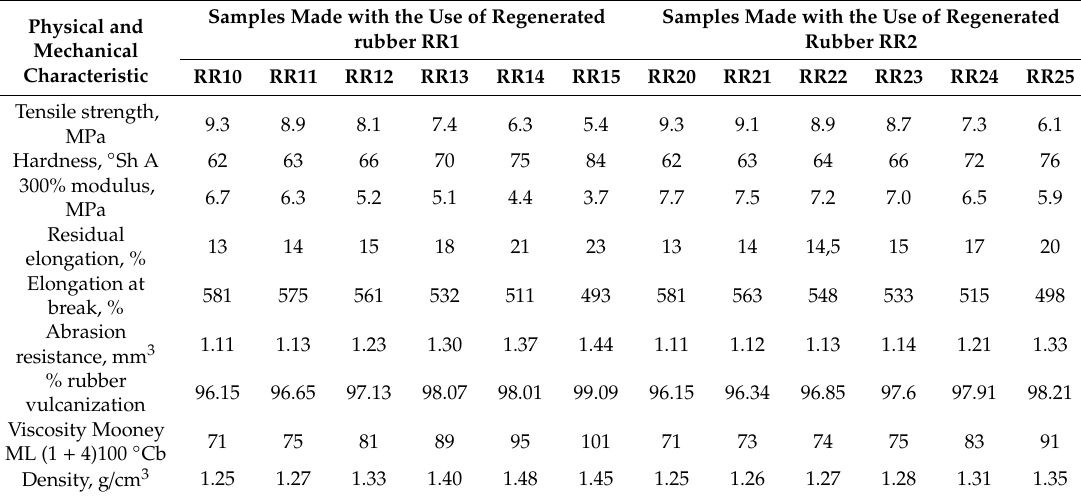
Table 7. The physical and mechanical characteristics of the rubber in the samples made using the two types of reclaimed rubber.